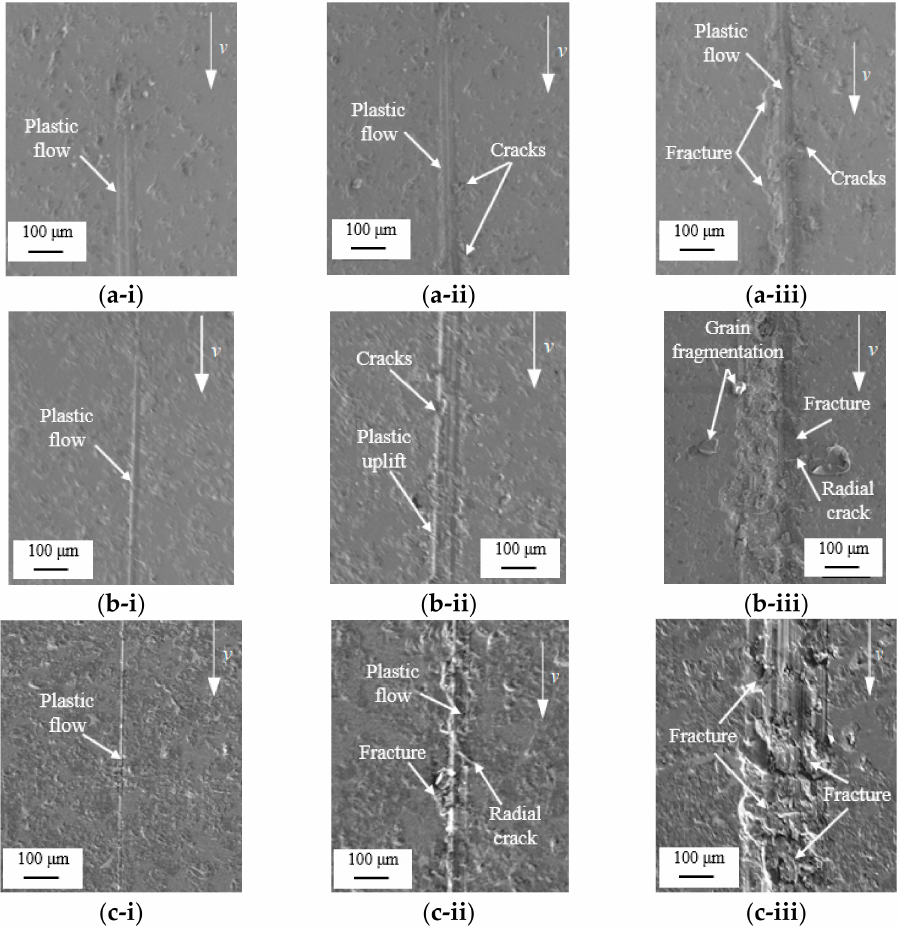
Figure 6. Surface integrity of the scratched RB-SiC ceramic sample at different material removal stages with corresponding scratching speeds. ( a-i ) DR stage, v s = 1 m/s; ( a-ii ) D-B-TR stage, v s = 1 m/s; ( a-iii ) BR stage, v s = 1 m/s; ( b-i ) DR stage, v s = 5 m/s; ( b-ii ) D-B-TR stage, v s = 5 m/s; ( b-iii ) BR stage, v s = 5 m/s; ( c-i ) DR stage, v s = 10 m/s; ( c-ii ) D-B-TR stage, v s = 10 m/s; ( c-iii ) BR stage, v s = 10